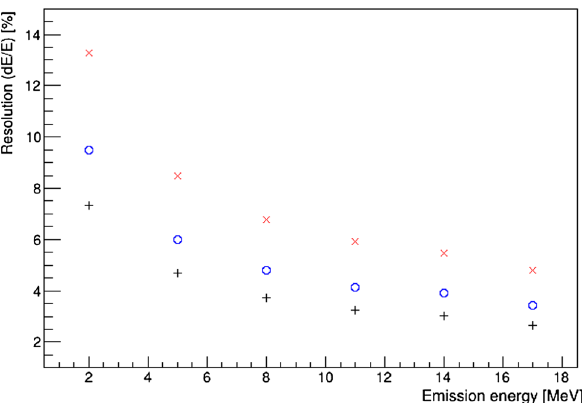
Fig. 22 Energyresolutionofasingleclovermeasuringelectronsenter- ing perpendicular to the center of its front face, as a function of the emission energy of the particles. The three data sets account for dif- ferent light-yields: 30 phe/MeV (red stars), 60 phe/MeV (blue circles), 100 phe/MeV (black crosses)